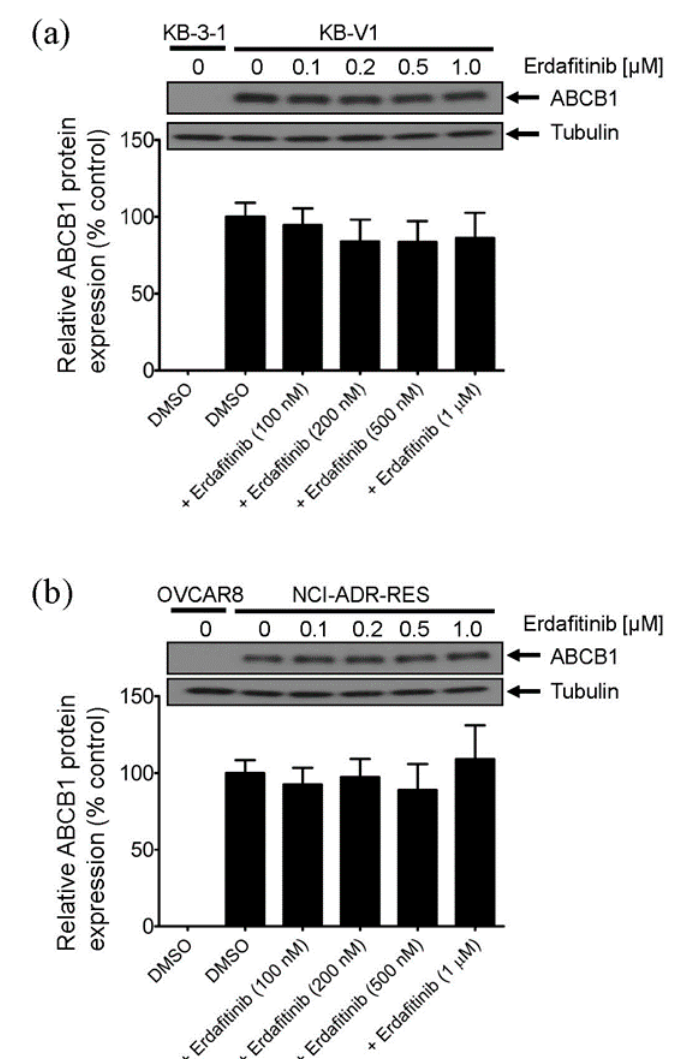
Figure 3. Erdafitinib does not alter the protein expression of ABCB1 in ABCB1-overexpressing cancer cells. ( a ) KB-V-1 cancer cells and ( b ) NCI-ADR-RES cancer cells were treated with DMSO (vehicle control) or erdafitinib at 100 nM, 200 nM, 500 nM, or 1 µ M for 72 h and processed for western blotting as described in the Materials and Methods. α -tubulin was used as an internal loading control. The representative immunoblots (upper panel) and the corresponding quantification (lower panel) human ABCB1 protein are shown. Values are presented as mean ± S.D. calculated from at least three independent experiments. Detailed information about western blot can be found in Figures S1 and S2.